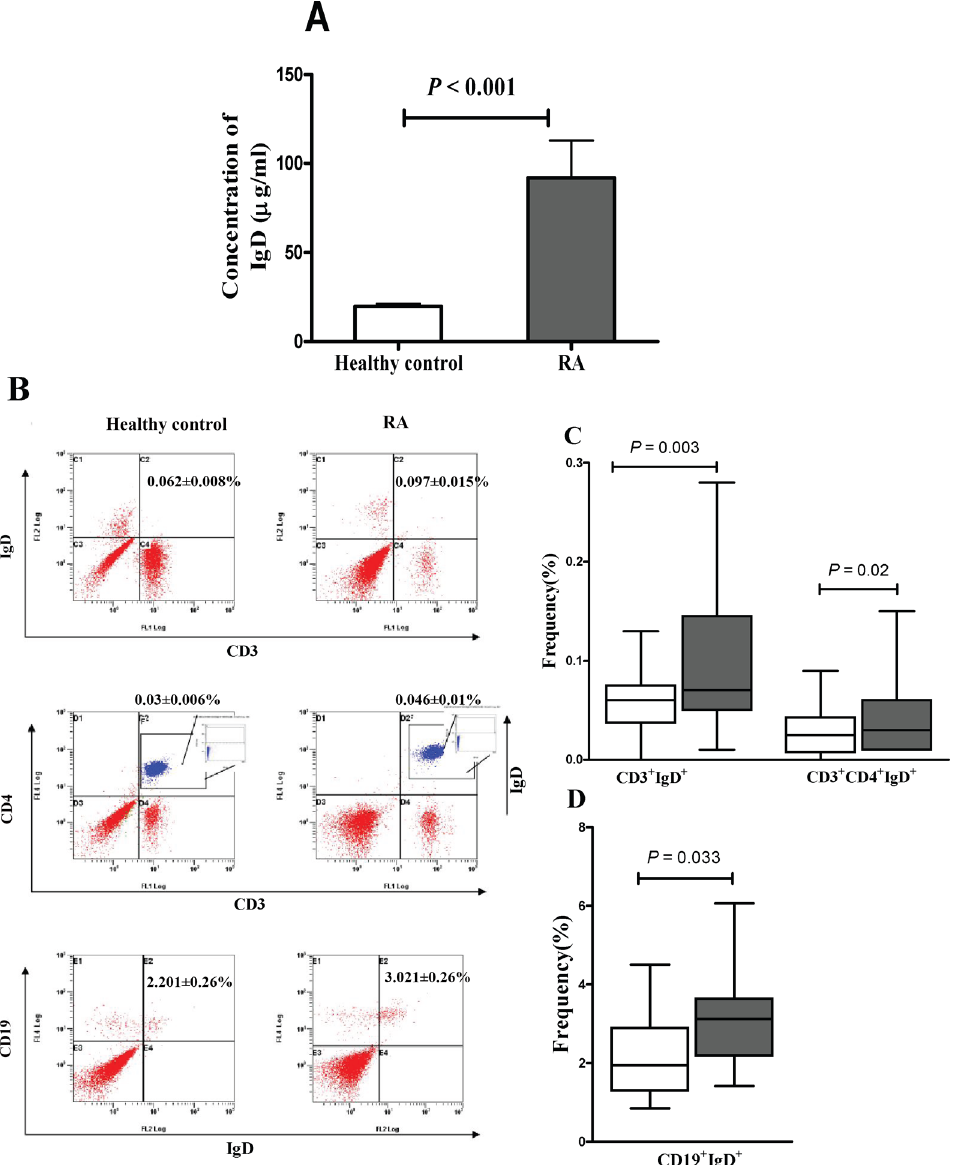
Fig 1. Levels of sIgD and mIgD in RA patients and healthy controls. (A): Serum IgD concentrations were significantly different in RA patients (n = 28) and healthy controls (n = 22) ( P < 0.001). (B): A dot plot showing the expression of IgD on T cells and B cells. (C) and (D): Box-plots representing the 10th, 25th, 50th (median), 75th and 90th percentiles of the frequencies of the CD3 + IgD + , CD3 + CD4 + IgD + and CD19 + IgD + (each as a percentage of lymphocytes) in the peripheral blood of healthy controls (n = 18, white bars) and RA patients (n = 20, grey bars). P < 0.05 was considered statistically